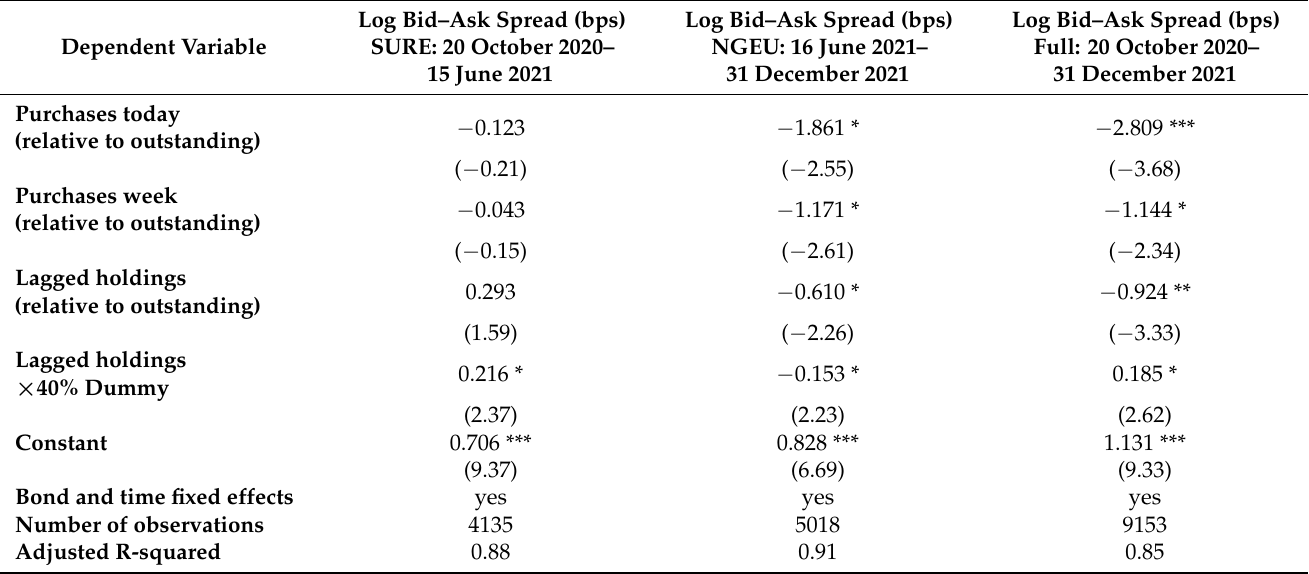
Table 3. Impact of Eurosystem purchases and holdings on market liquidity. Panel regression estimates of log bid–ask spreads on Eurosystem purchases and lagged holdings. Different columns indicate different estimation samples, namely, between 20 October 2020 and 15 June 2021 (“SURE”), between 16 June 2021 and 31 December 2021 (“NGEU”), and the union of the two (“Full sample”). Standard errors are in brackets below and clustered at the bond level ( N = 37). *, **, and *** refer to 0.1, 0.05, and 0.01 statistical significance